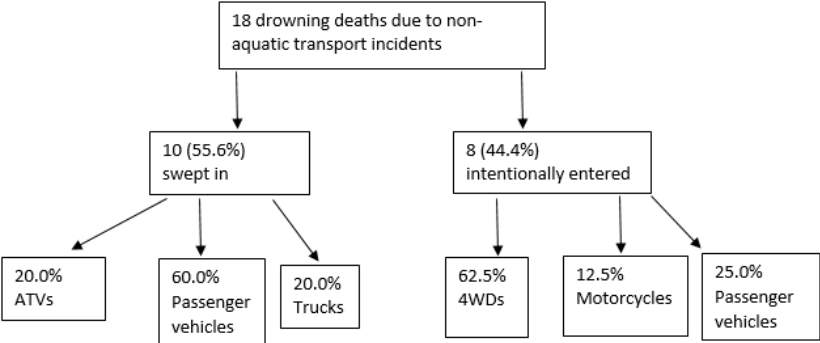
Figure 3. Flow chart exploring non-aquatic transport flood related child and adolescent drowning deaths, 0–19 years by age group, Australia, 2002/03–2017/18 (n = 18).